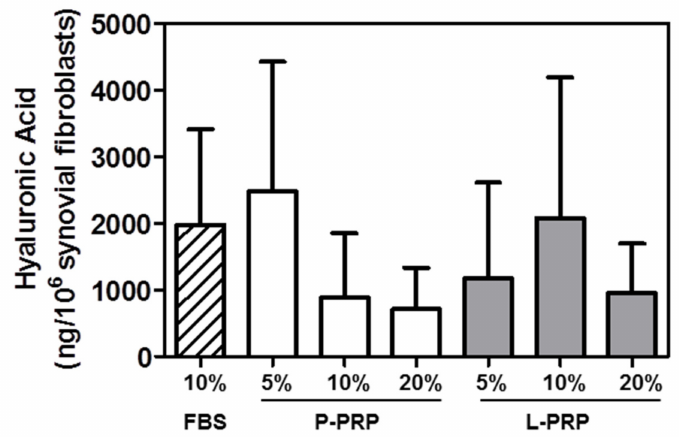
Figure 6. Hyaluronic acid production from synovial fibroblasts incubated with P-PRP and L-PRP. Hyaluronic acid protein production was normalized per number of synovial fibroblasts, and results are reported as means and standard deviations. Statistical analysis was performed by Wilcoxon matched pairs test and Friedman Anova